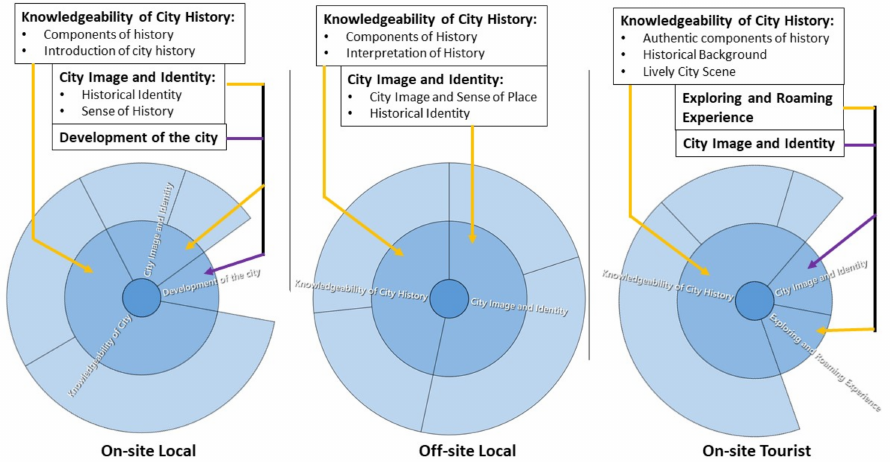
Figure 9. Results of theme—revival of urban